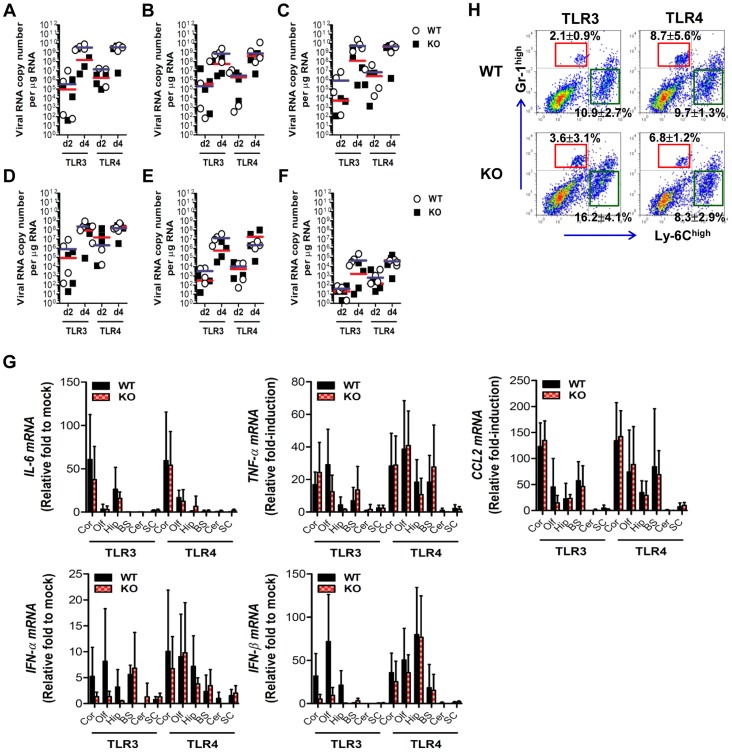
The spread of JEV in the brain of TLR3−/− and TLR4−/− mice after intracranial inoculation.TLR3−/− and TLR4−/− mice were inoculated with JEV (103 pfu) by intracranial injection. Brains were harvested on days 2 and 4 pi, and then used for the determination of viral spread and cytokine expression. A–F. Viral burden in each sub-tissue of brain. The CNS tissues were separated into cortex (A), olfactory bulb (B), hippocampus (C), brain stem (D), cerebellum (E), and spinal cord (F). Viral burden was determined by real-time qRT-PCR. The viral RNA load was expressed by viral RNA copy number per microgram of total RNA. Each symbol represents the level of an individual mouse; the horizontal line indicates the median of each group. G. The expression levels of pro-inflammatory cytokine and type I IFN genes in each sub-tissue of brain. The expression levels were expressed by the indicated target gene levels relative to those in the mock-infected group. The bar represents the average ± SD of the indicated target gene levels obtained from each group (n = 5). Cor, cortex; Olf, olfactory bulb; Hip, hippocampus; BS, brain stem; Cer, cerebellum; SC, spinal cord. H. Leukocyte accumulation in the CNS of TLR3−/− and TLR4−/− mice after intracranial infection of JEV. TLR3−/− and TLR4−/− mice were inoculated with JEV (103 pfu) by intracranial injection, and brains were harvested on day 2. Leukocyte populations were isolated by vigorous heart perfusion and then determined by flow cytometric analysis. The values in the representative dot-plots denote the average of the indicated cell population obtained from three individual experiments.